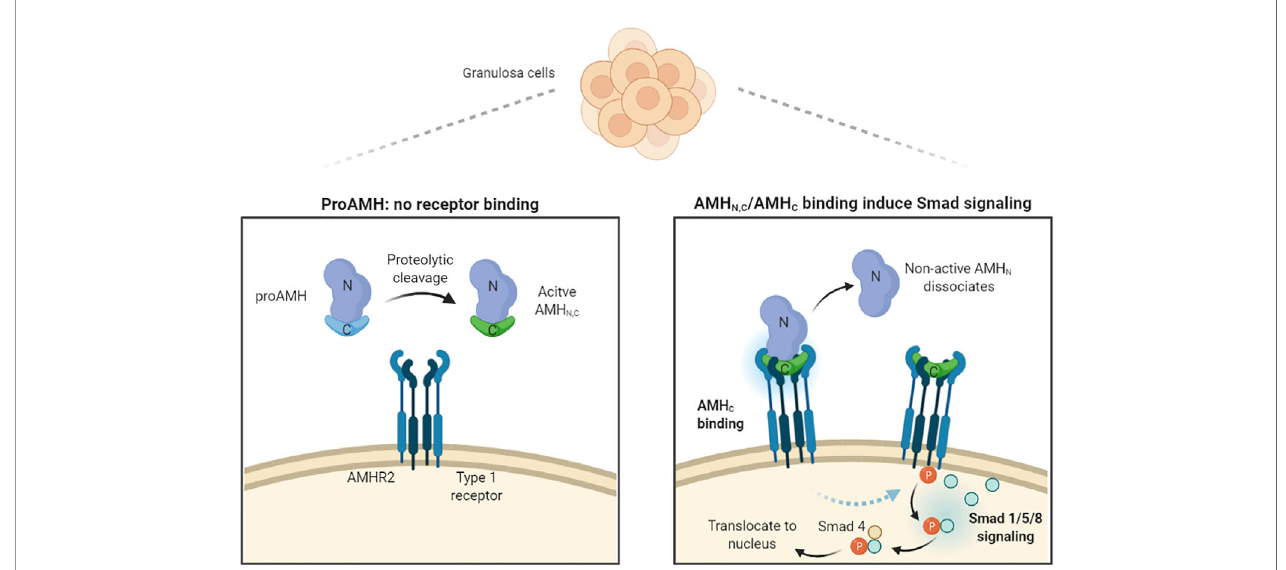
FIGURE 1 | Schematic illustration of AMH processing, receptor binding, and induction of intracellular signals. AMH is produced by GCs as an inactive promature precursor (proAMH) that is not receptor competent. Proteolytic cleavage of proAMH generate a noncovalently associated form (AMH N,C ) that can bind to the speci fi c AMH receptor 2 (AMHR2). Upon binding to the pro region (AMH N ) dissociates. Both AMH N,C and AMH C are capable of activating receptors. AMHR2 and the common Type 1 receptor phosphorylate Smads 1, 5, and 8, which bind to Smad 4, enter the nucleus and turn on AMH-responsive genes. Illustration modi fi ed from Josso (23) and created with